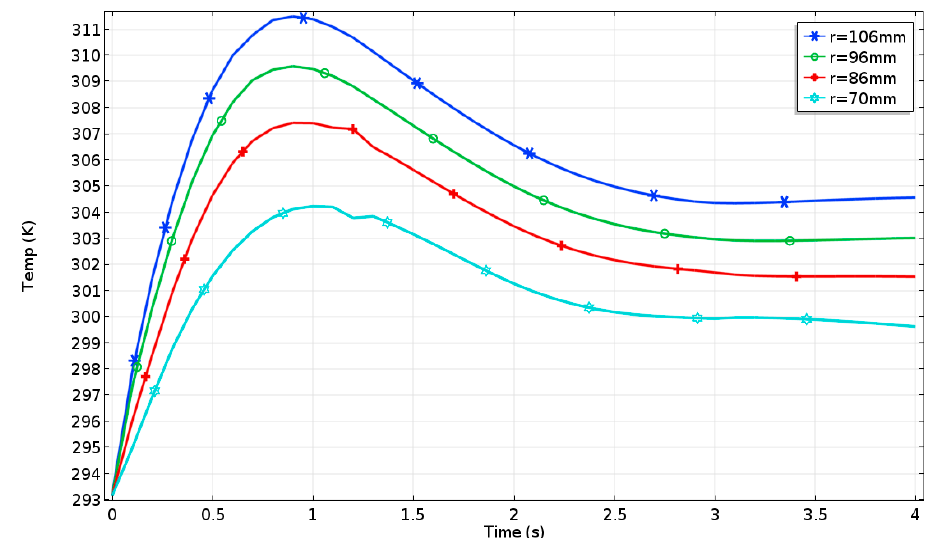
Figure 9. Radial temperature distribution of the electromagnetic brake surface.